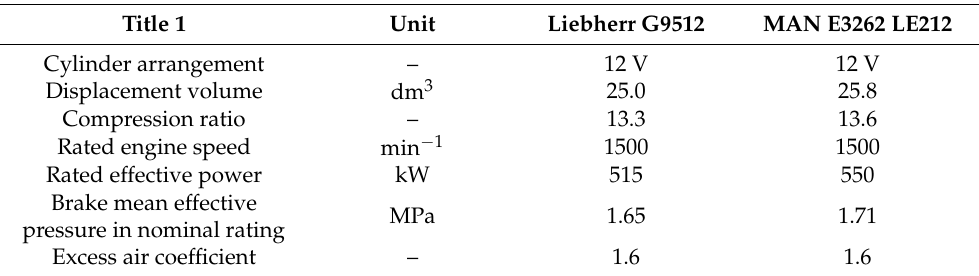
Table 2. Technical data of tested Liebherr G9512 and MAN E3262 LE212 stationary CHP engines used in agricultural biogas plants.